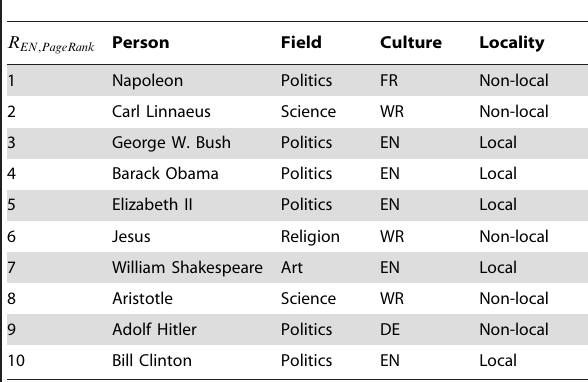
Table 2. Example of list of top 10 persons by PageRank for English Wikipedia with their field of activity and native language.